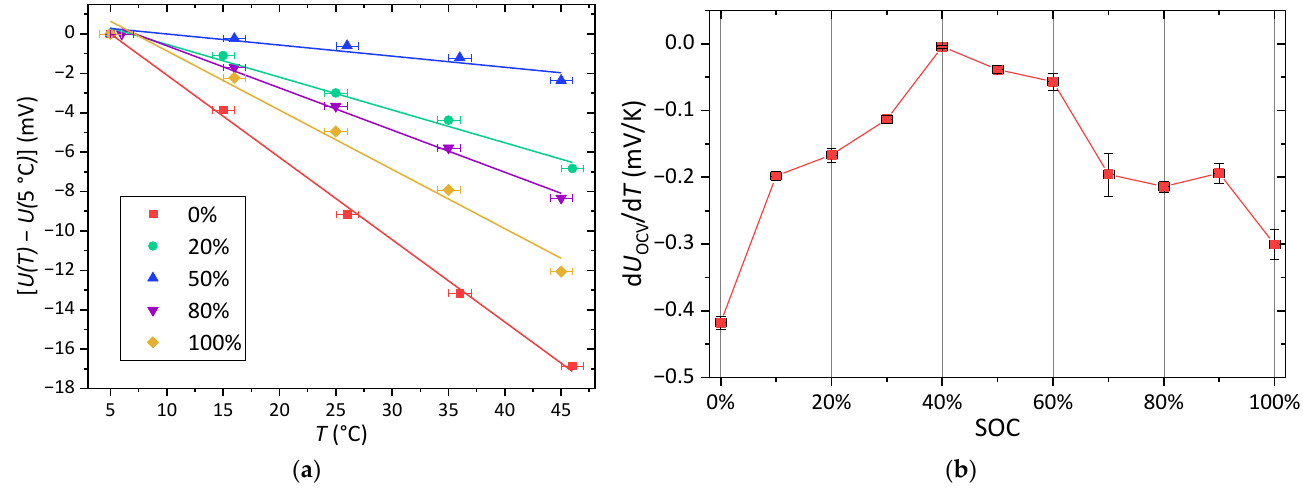
Figure 2. SOC-dependent voltage variation with temperature: ( a ) battery voltage as a function of temperature related to the voltage at 𝑇 ≈ 5 °C for selected SOC values with corresponding linear fits. ( b ) Slopes of the linearized voltage variation with temperature depending on the SOC. A line is drawn to guide the eye.